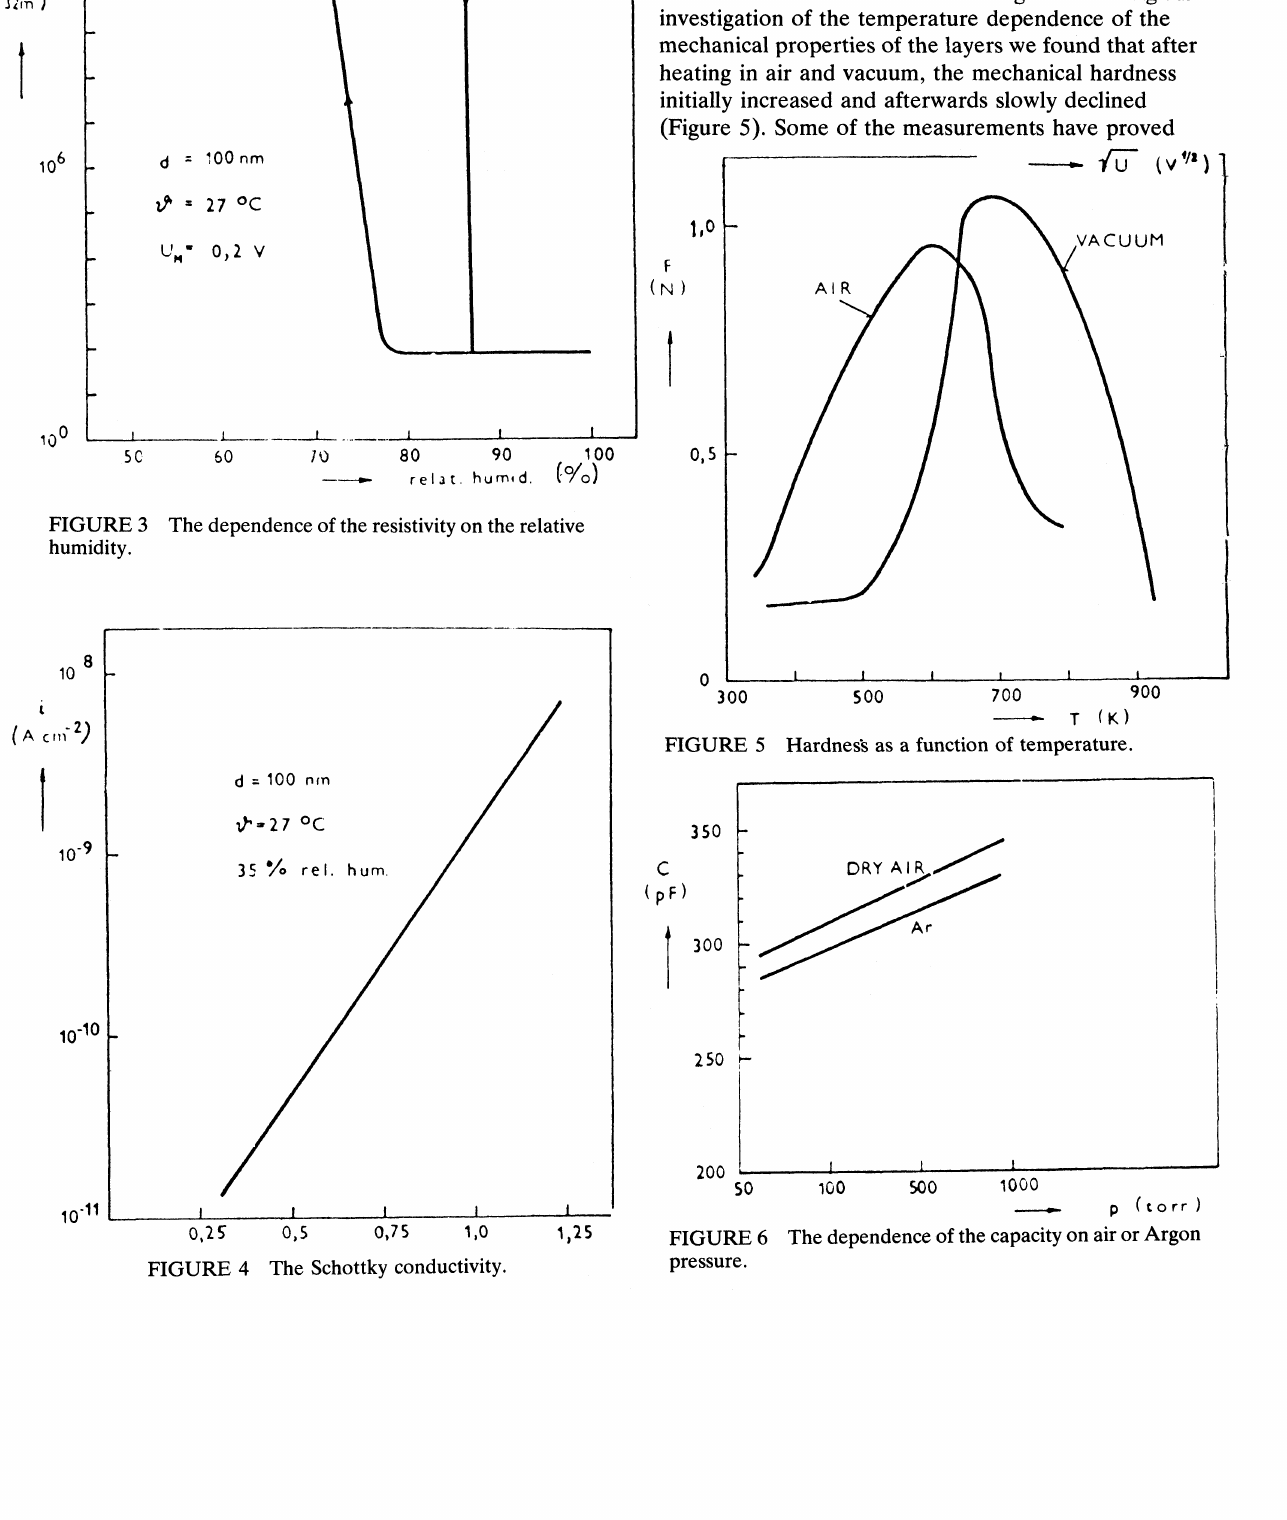
FIGURE 6 The dependence of the capacity on air or Argon